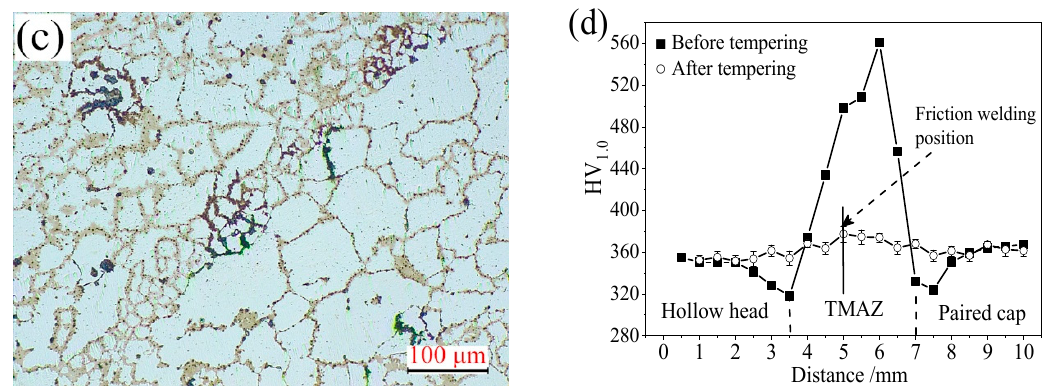
Figure 9. ( a ) Schematic diagram of hardness measurement across thermo-mechanically affected zone (TMAZ); ( b – c ) microstructure in TMAZ ( d ) results of hardness revolution across TMAZ before and after tempering.